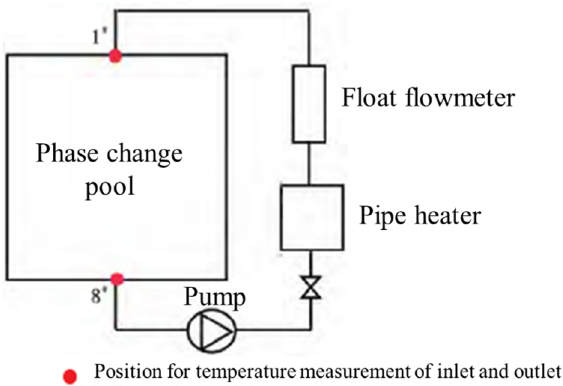
Figure 1. Schematic diagram of experimental heat storage system for phase change cooling reservoir of air-conditioning.